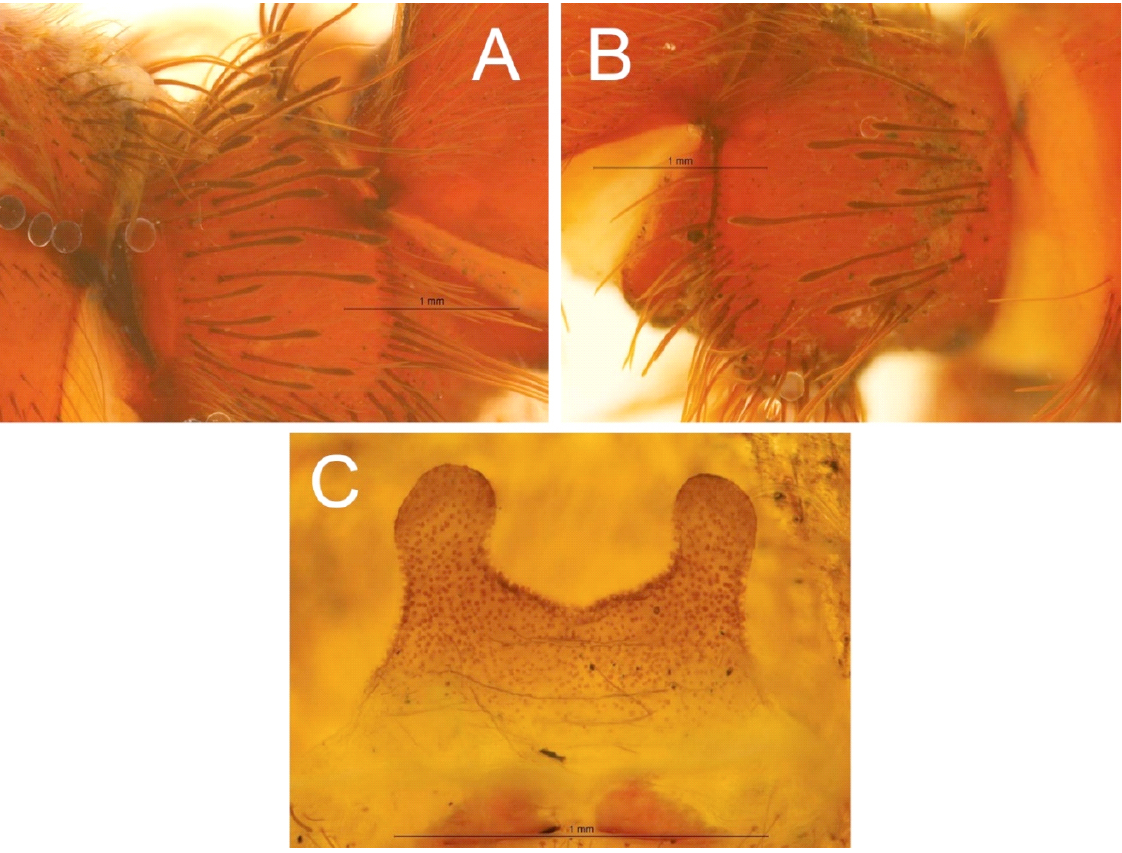
Fig. 3. Longilyra johnlonghorni Gabriel, 2014, ♀, Santa Ana, Laguna de Las Ninfas, El Salvador (SMF 8582/2). A . Palp, trochanter, stridulatory organ. B . Trochanter I, stridulatory organ. C . Spermathecae, dorsal. From Gabriel (2014: figs 1, 2,